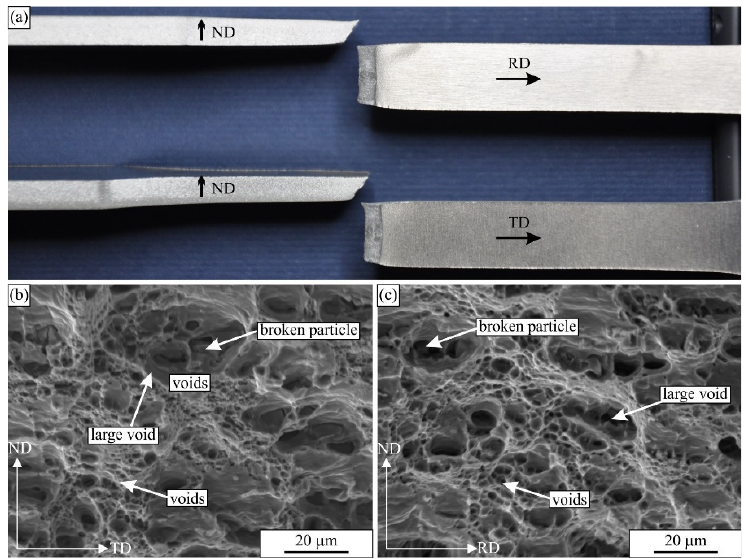
Figure 5. The fractured tensile specimens. ( a ) The photography of the samples. The secondary electron micrographs of the fractured surfaces of the tensile specimens: ( b ) in the RD and ( c ) in the TD.